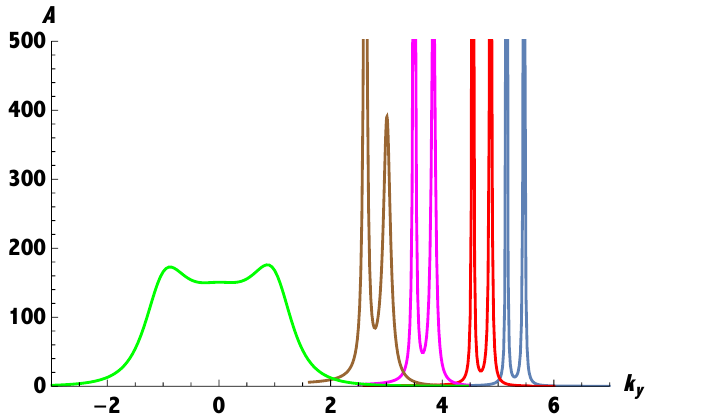
Figure 3. Plot of spectral function A vs. k y with k x = π in absence of ionic lattice with different fermionic charges. q = 8.7 (blue), 8.5 (red), 8.2 (magenta), 8 (brown), 7.7 (Green). The height of some of the plots are truncated so as to get all the peaks visible in the